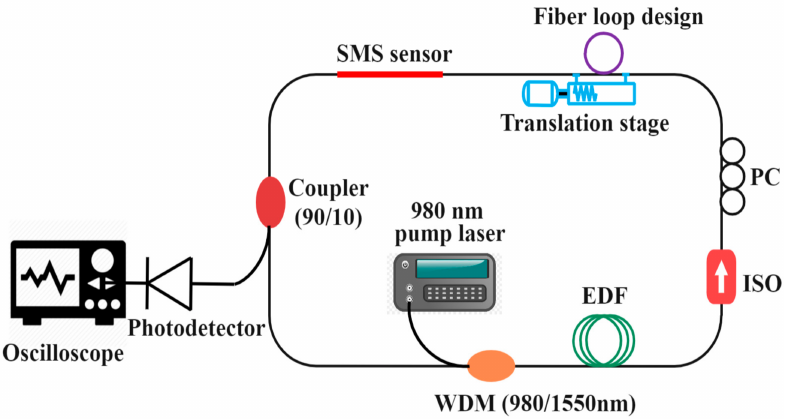
Figure 1. Experimental setup of ultrasonic vibration detection using SMS fiber structure and fiber ring cavity